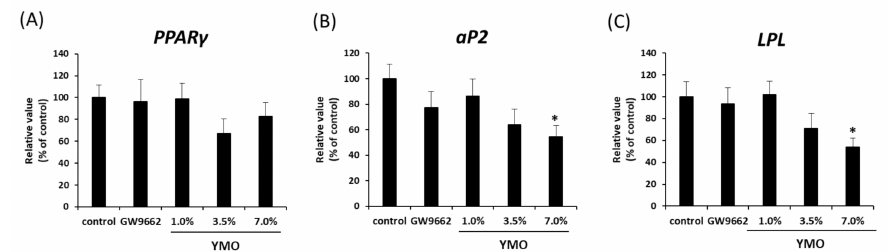
Figure 4. Effect of YMO on the expression of adipocyte differentiation marker genes in perirenal adipose tissue in KK-A y mice. Perirenal adipose tissue was collected from KK-A y mice fed with 1.0, 3.5, or 7.0% YMO for 16 weeks. mRNA expression levels of PPAR γ ( A ), aP2 ( B ), and LPL ( C ) were measured by real-time PCR. Relative mRNA expressions were expressed as percentage of control. Values are mean ± SE, n = 10–11. * p < 0.05 versus control.